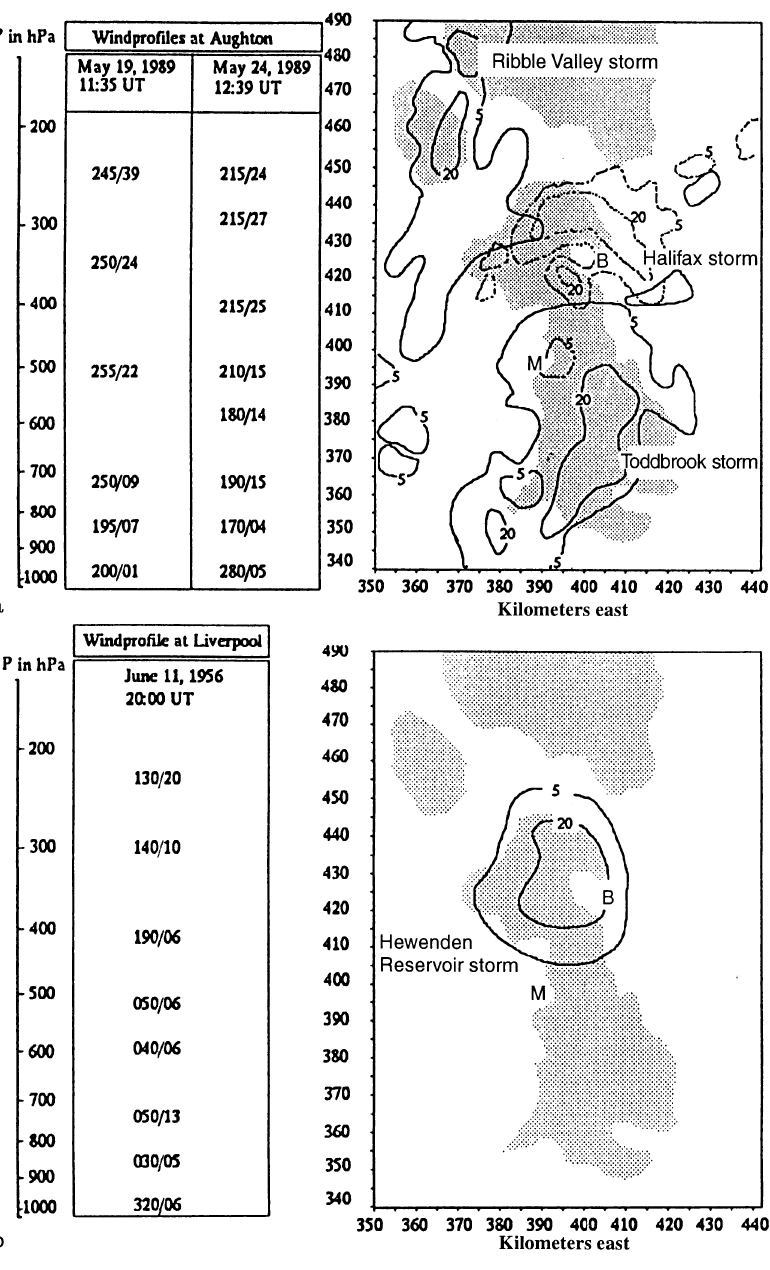
Fig. 10a, b. Wind profiles with height and storm totals of a three storms that developed during southerly to southwesterly winds. The contours for those storms that developed on 24 May 1989 are drawn in solid lines , those for the storm on 19 May 1989 in dashed lines , b one storm that developed during northeasterly flow. The 5 mm and 20 mm isohyets are drawn, the wind directions are given in degrees and the speed in